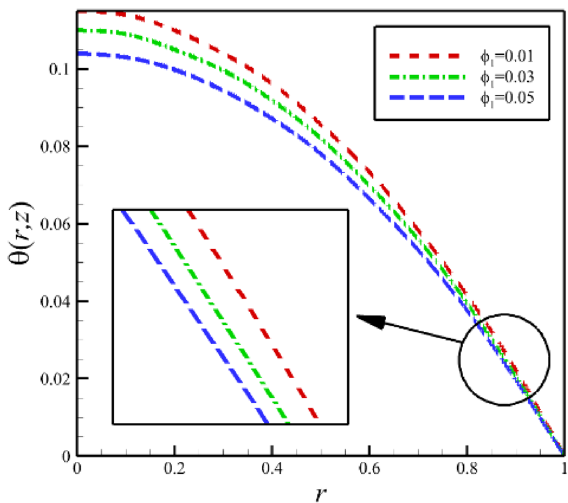
Fig. 10 The influence of variation Cu